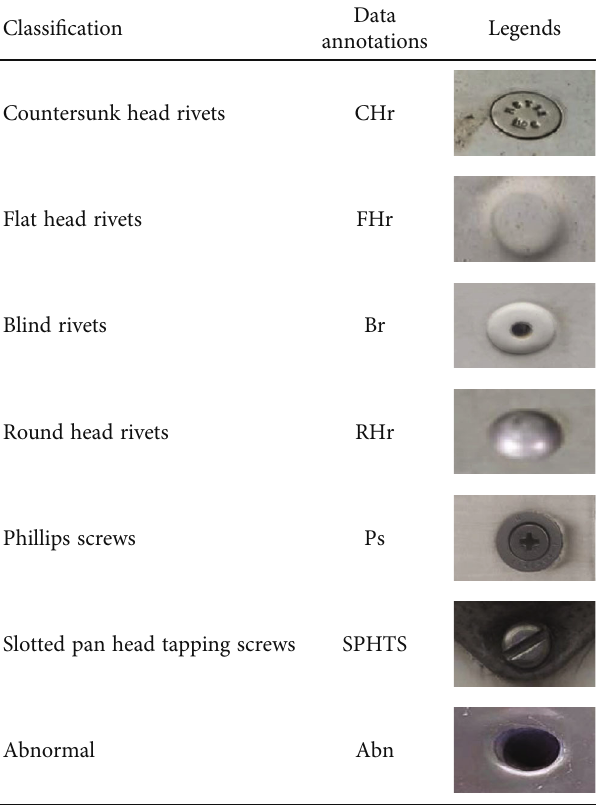
Table 1: Rivet classi fi